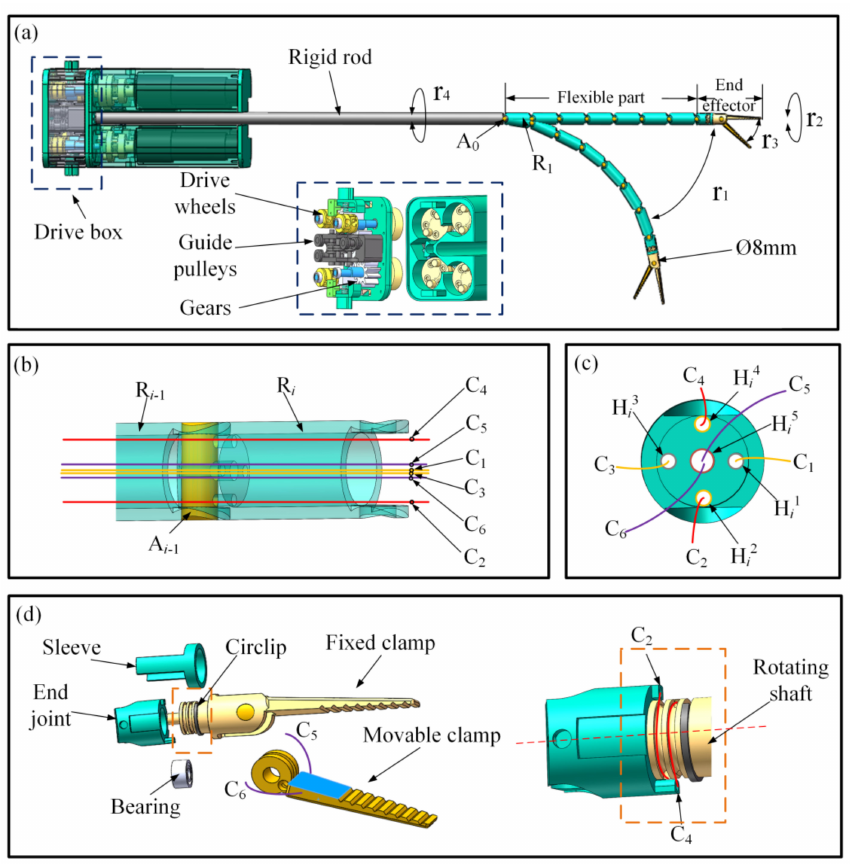
Figure 1. Structural analysis of the flexible surgical instrument: ( a ) surgical instrument; ( b ) connection of two segments; ( c ) traction cables of the flexible part; ( d ) structure of the